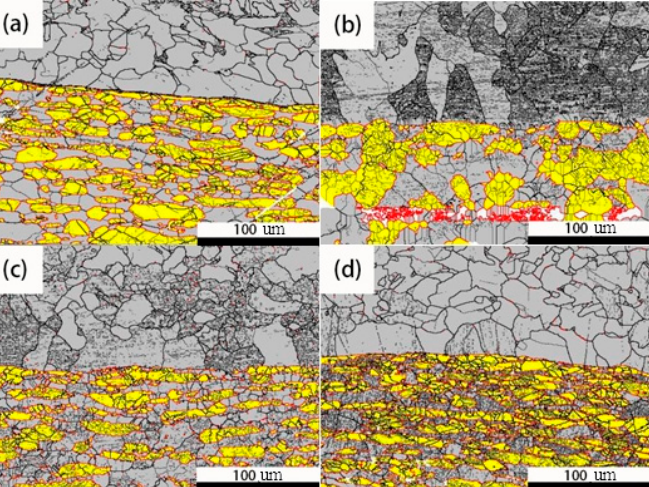
Figure 9. Phase boundary and grain boundary diagrams of large deformation regions at different rates at 1050 °C. ( a ) 0.01 s − 1 ; ( b ) 0.1 s − 1 ; ( c ) 1 s − 1 ; ( d ) 10 s − 1